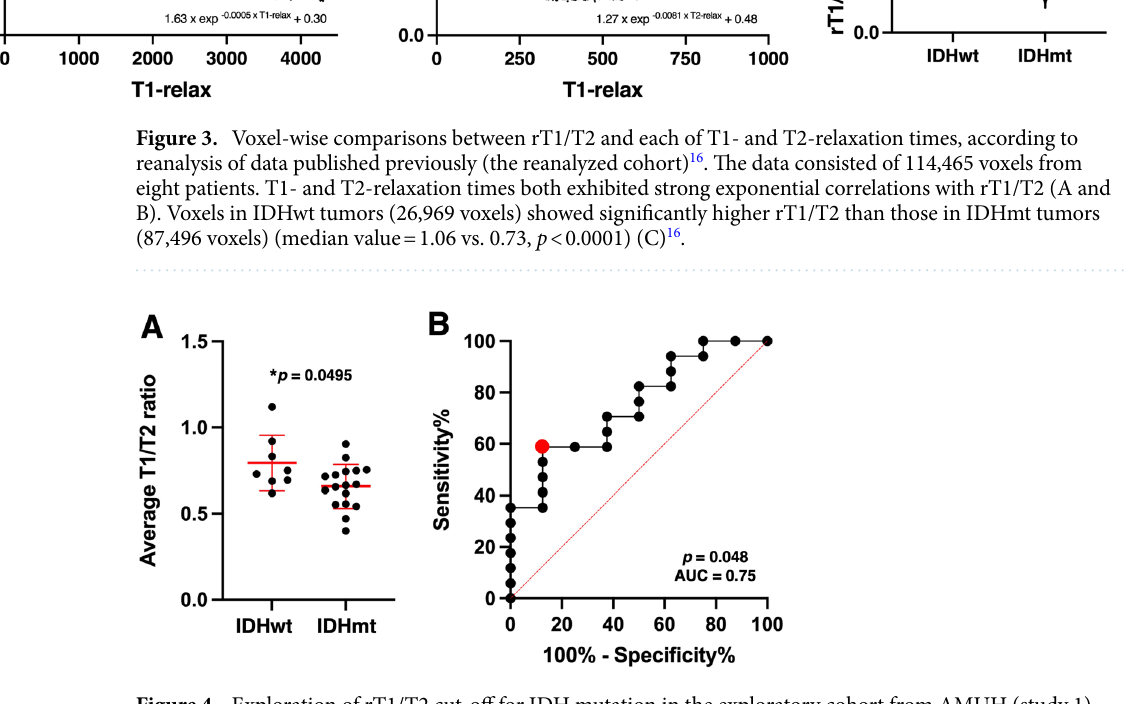
Figure 4. Exploration of rT1/T2 cut-off for IDH mutation in the exploratory cohort from AMUH (study 1). ( A ) There was statistically significant difference in mean rT1/T2 between the IDH-wildtype and IDH-mutant groups ( p = 0.0495 < 0.05) ( A ). ROC curve for detecting IDH-mutant LrGGs shows AUC of 0.75, p = 0.0486. The red star indicates an ideal cut-off for mrT1/T2 of < 0.677, with sensitivity of 58.8% and specificity of 87.5% ( B ).